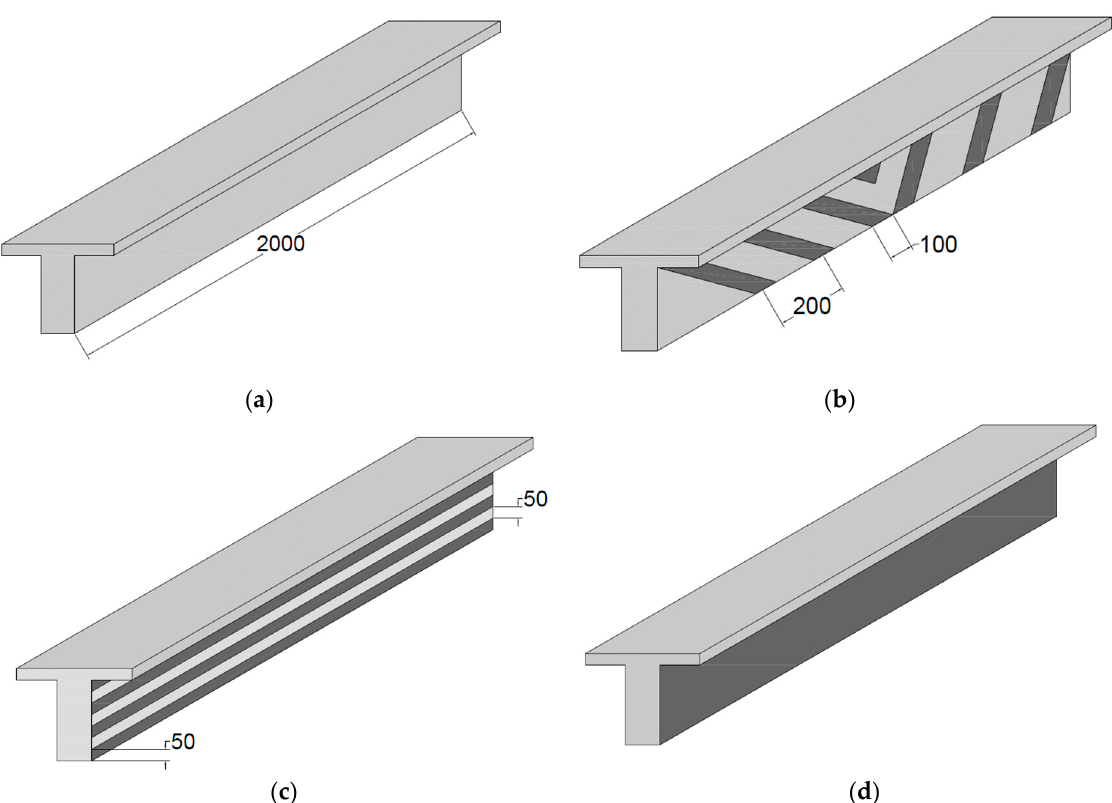
Figure 2. Beams groups: ( a ) control group 1; ( b ) inclined 45° CFRP-group 2; ( c ) horizontal straight CFRP-group 3; ( d ) U-wrap CFRP-group 4. Table 7. Test specimen notations.